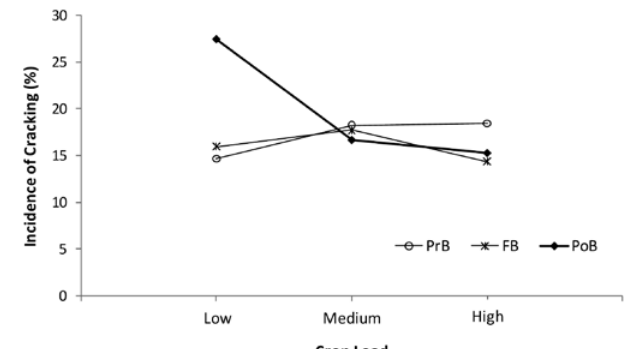
Fig. 2 - Incidence of total cracking at Huonville for variety ‘Sweet- heart’ under low, medium and high crop loads applied at dor- mant bud stage (PB), full bloom (FB) and four weeks after full bloom (PoB). A significant interaction between crop load level and application timing was evident; low crop load resulted in a significantly higher level of cracking within the post bloom application time